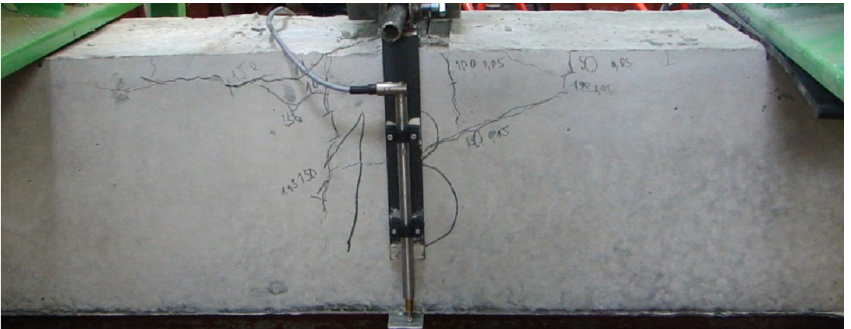
Figure 8. Combined failure—specimen 1B.